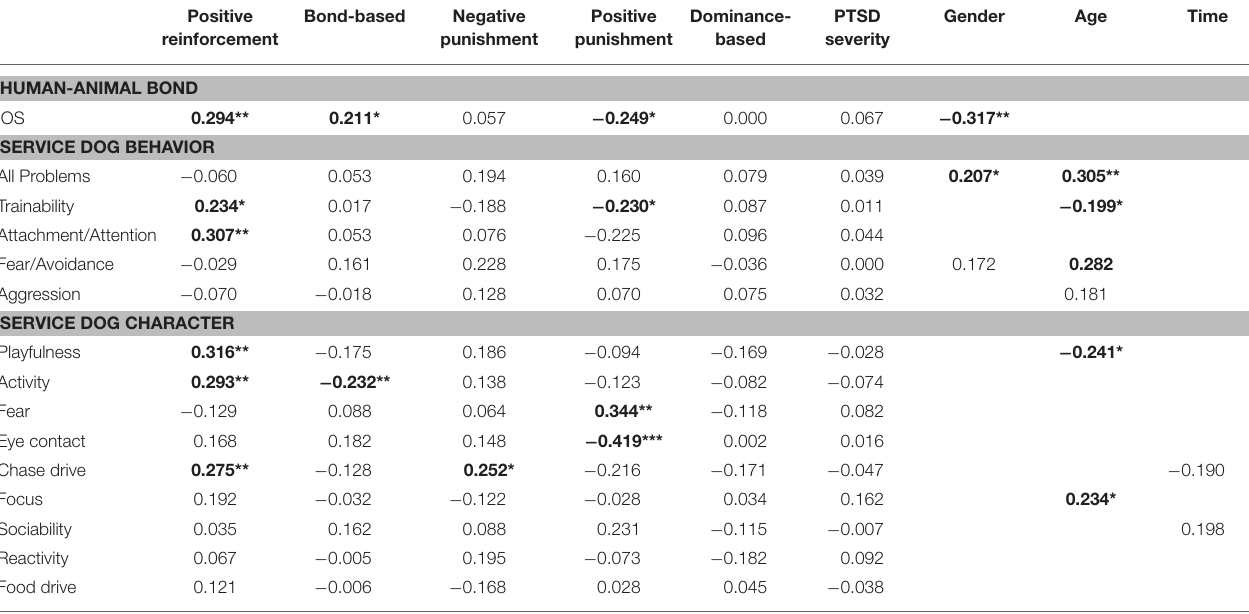
TABLE 2 | Associations between training methods, PTSD Severity, veteran-service dog closeness (IOS), and service dog behavior and